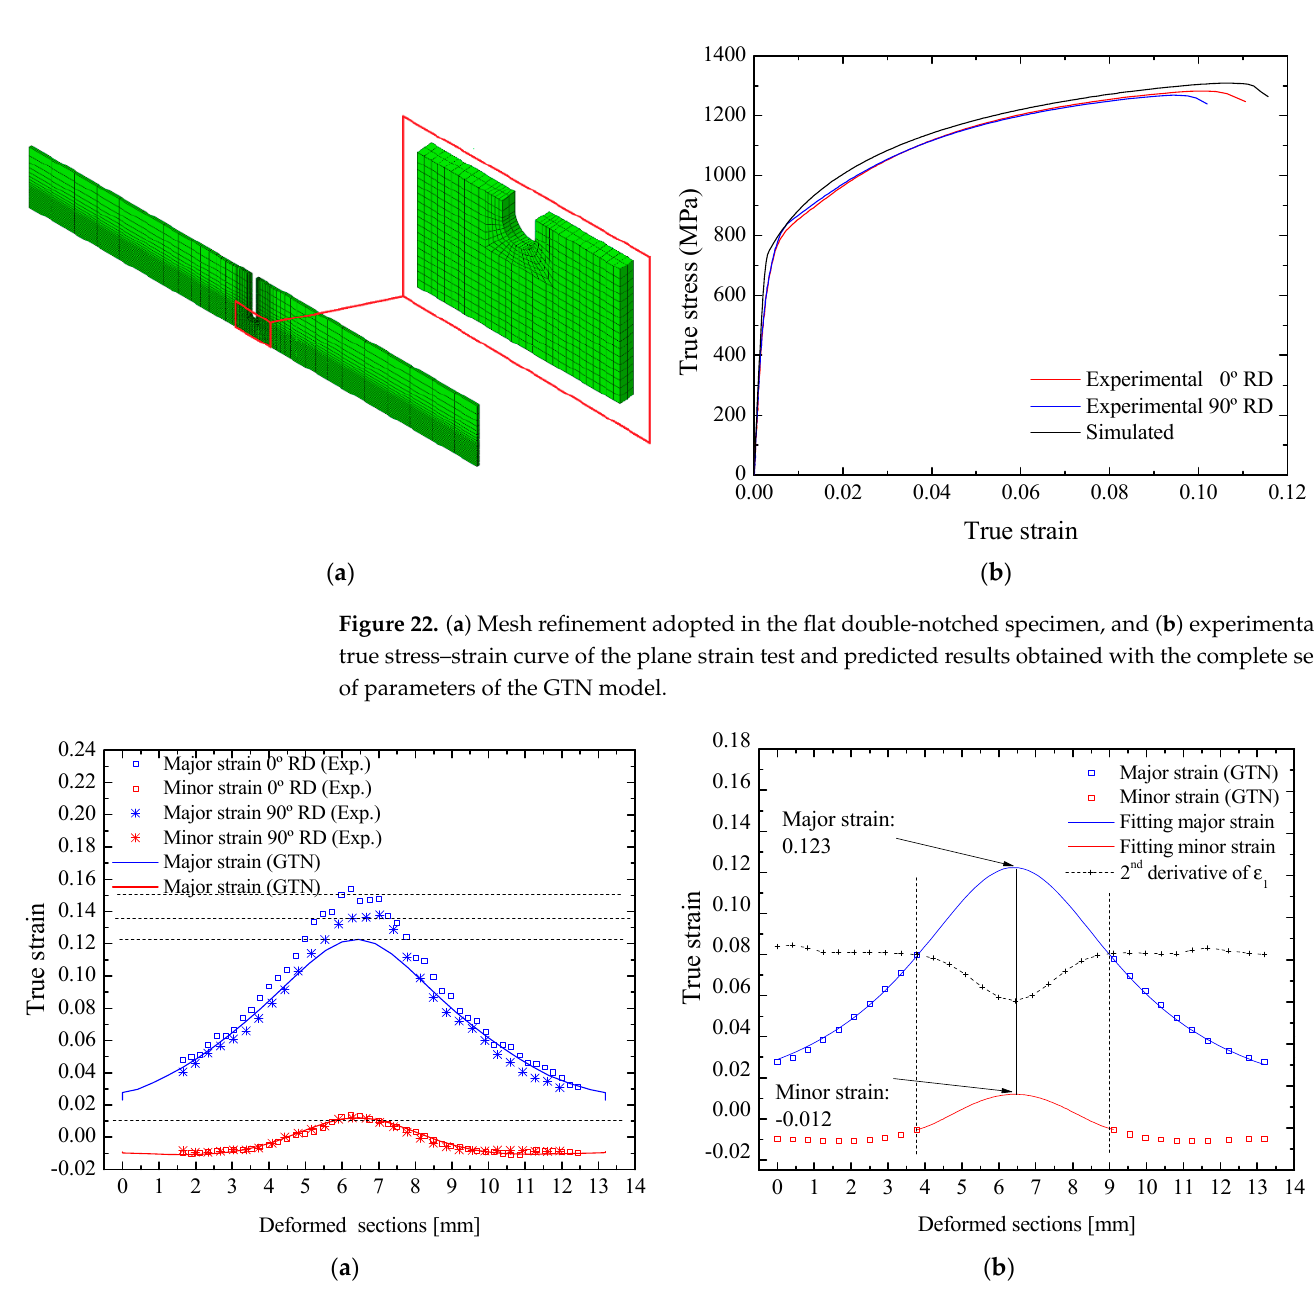
Figure 24. Comparison between the experimental left-hand side of the forming limit curve and the numerical prediction determined for the CR980XG3 TM steel sheet using flat specimens and the GTN model.